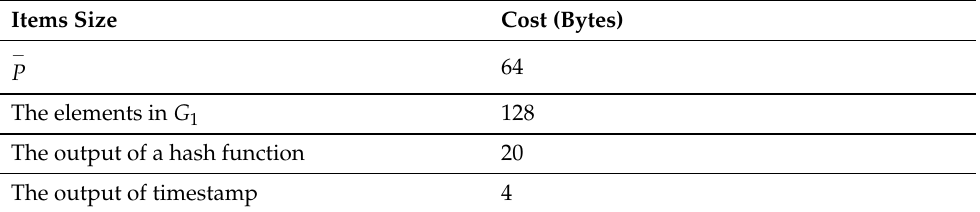
Table 6. The costs of several bilinear pairing